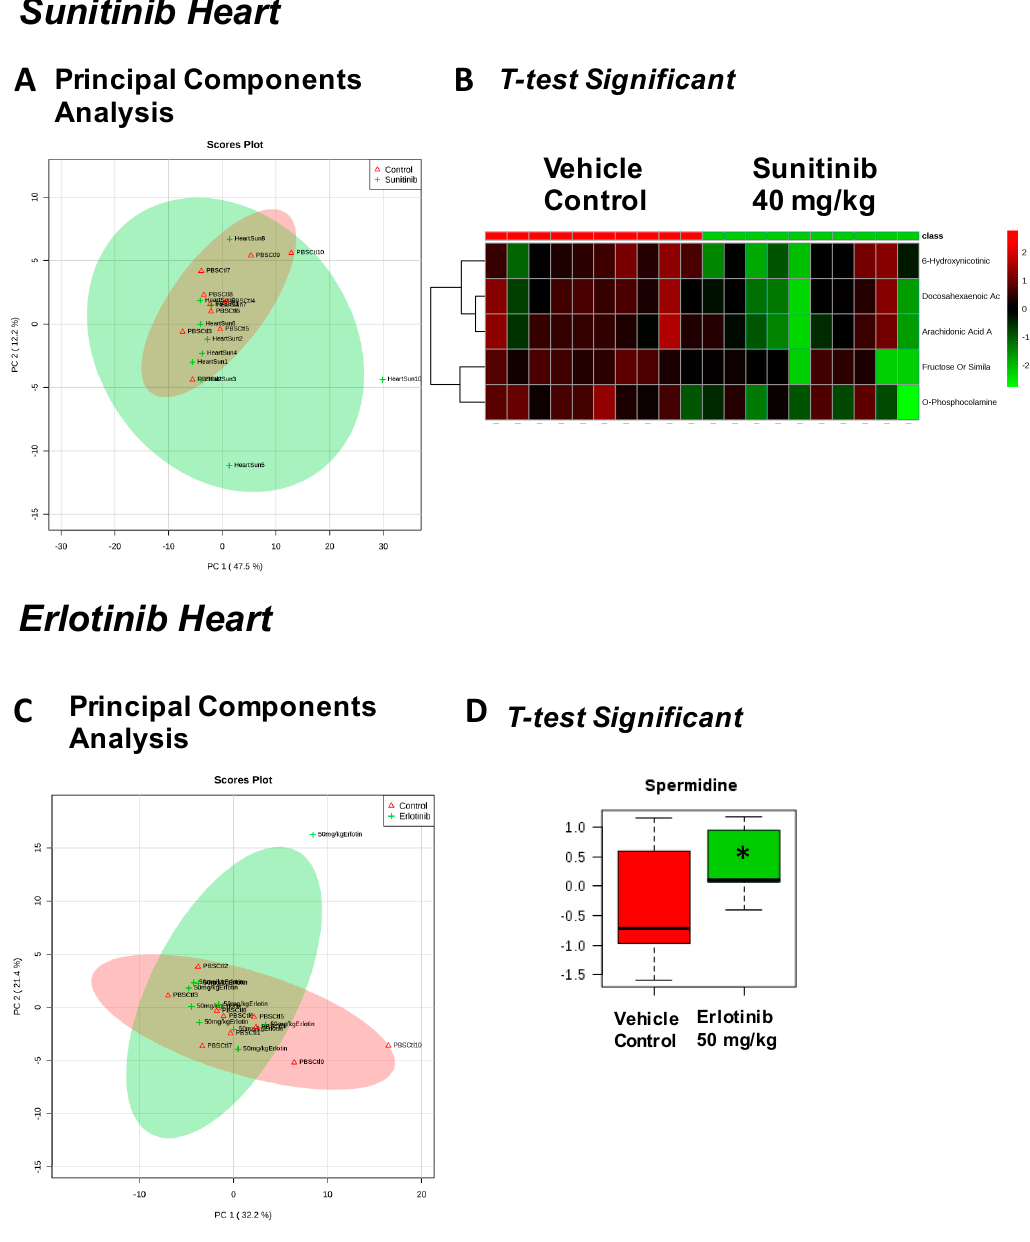
Figure 2. Significant metabolites identified in the heart 2 weeks after tyrosine kinase inhibitor (or vehicle control) treatment. PCA (principal components analysis) of metabolites identified in sunitinib-treated heart ( A ). t -test significant metabolites identified in sunitinib-treated heart ( B ). PCA (principal components analysis) of metabolites identified in erlotinib-treated heart ( C ). t -test significant metabolites identified in erlotinib-treated heart ( D ). N = 10/group